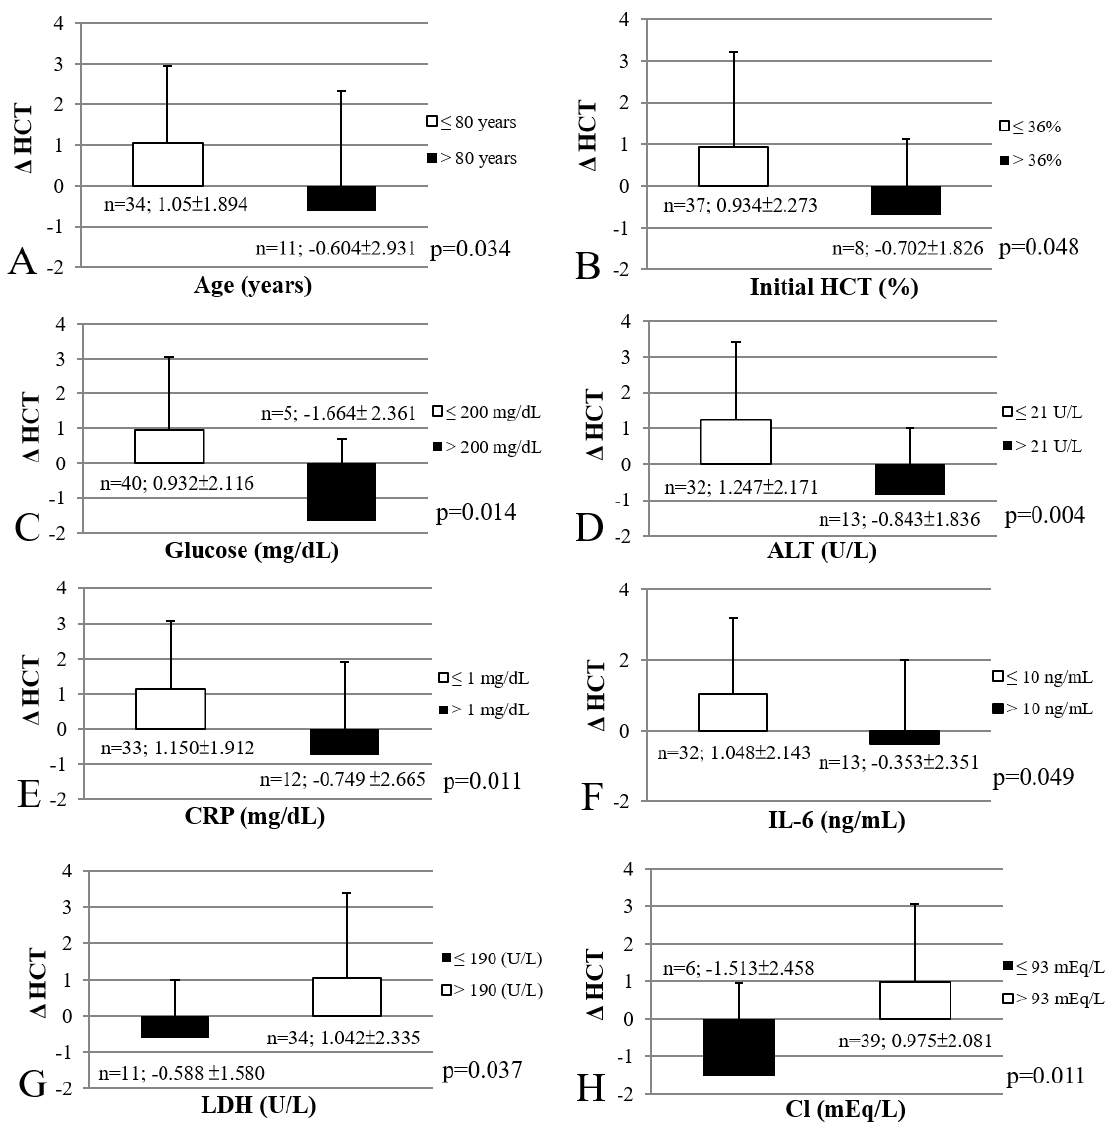
Figure 3. Subgroup analyses of significant factors associated with erythropoietic response. Abbreviations: HCT, hematocrit; ALT, alanine aminotransferase; CRP, c-reactive protein; IL-6, interleukin-6; LDH, lactate dehydrogenase; Cl, chloride; ∆ HCT, change in HCT level from phase 1 to phase 3. Patients were further grouped according to the number of poor erythropoietic fac- tors they exhibited (group 1: no poor erythropoietic response factor, group 2: one poor erythropoietic response factor, group 3: two poor erythropoietic response factors, and group 4: three or more poor erythropoietic response factors), and the analysis of their erythropoietic responses is shown in Table 2. Group 1 demonstrated a significant increase in HCT levels (2.3%), followed by group 2 (1.2%). It was evident that as the number of poor erythropoietic response factors increased, the magnitude of the increase in HCT levels decreased, indicating a poor erythropoietic response. Group 3 only had a 0.1% increase in HCT levels, whereas group 4 had a 1.3% decrease in HCT levels. This suggests that patients with less than two poor erythropoietic response factors may benefit from a strategy of increased frequency of a fixed CERA